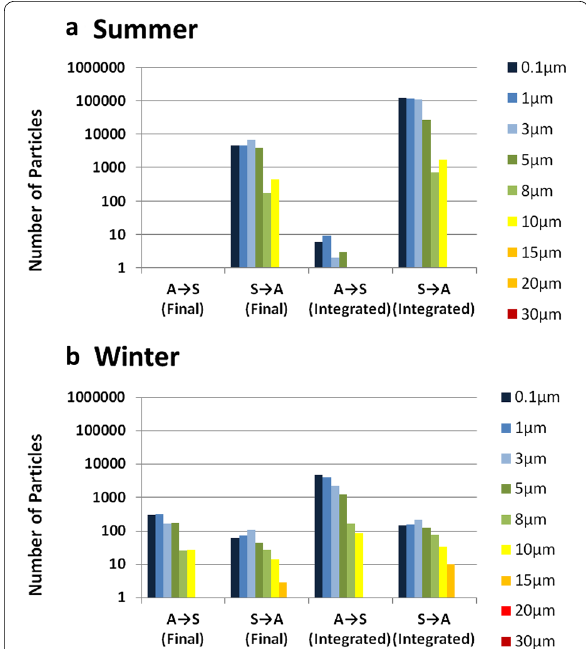
Fig. 5 Final and integrated numbers and size distribution of soil particles exchanged between Sakiyama and Amitori bays during a summer and b winter. The final and integrated values mean the values at the end of the simulations and those integrated during the simulations, respectively